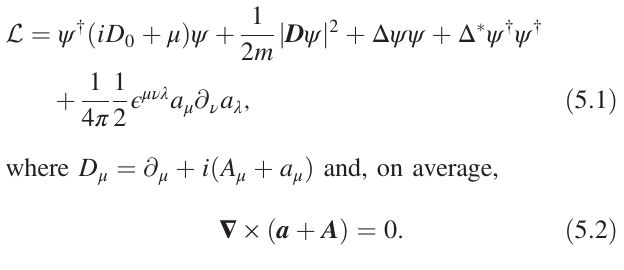
≫ Δ , thesystem u PDW